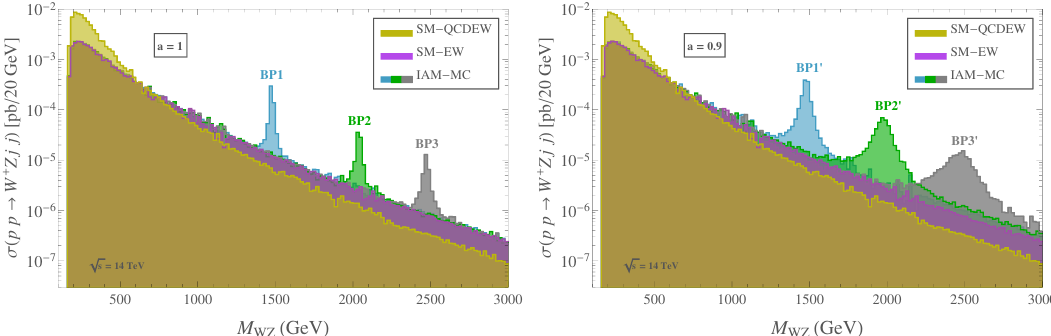
Figure 13 . Predictions of the (cid:27) ( pp W + Zjj ) distributions with the invariant mass of the WZ ! pair, M WZ , for the benchmark points of the IAM-MC model BP1 (blue), BP2 (green), BP3 (gray) in the left panel and BP1’ (blue), BP2’ (green), BP3’ (gray) in the right panel, and of the two main SM backgrounds, SM-QCDEW (yellow) and SM-EW (purple). The cuts in eq. (5.1) have been